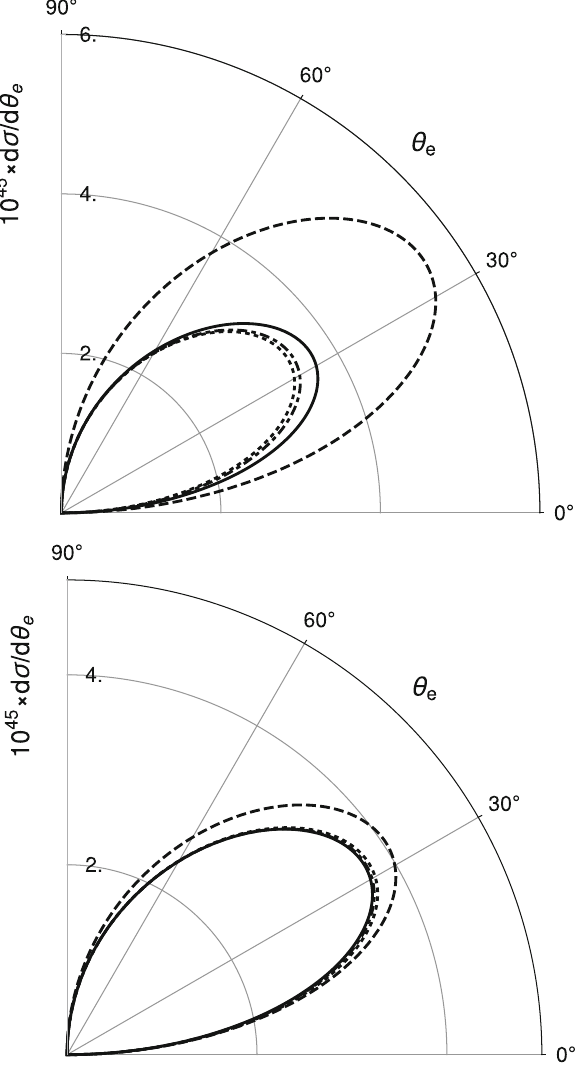
Fig. 9 Plot of d σ/ d θ e as a function of θ e for θ ν = π/ 2, E ν = 1 MeV , | = 0 . 2 ,θ = 0 T , R φ ν = 0. Upper plot for TRSC: standard V − A interaction (solid line); T | = 0 . 2 ,θ = 0 S , R | = 0 . 2 ,θ = 0 (dashed S the combination of V − A and T R when | c R T , R T | = 0 . 2 ,θ = 0(dashed-dotted P , R | = 0 . 2 ,θ = 0(dottedline); P line);thecaseof V − A and S R when | c R S , R S | = 0 . 2 ,θ = 0 (dashed-dotted line). Lower V − A with P R when | c R | = 0 . 2 ,θ = π/ 2 (dashed P , R P T , R T plot for TRSV: standard V − A interaction (solid line); the combination | = 0 . 2 ,θ = π/ 2 (dotted S , R | = 0 . 2 ,θ = π/ 2 (dashed line); the case S of V − A and T R when | c R T , R T | = 0 . 2 ,θ = π/ 2 (dashed-dotted P , R | = 0 . 2 ,θ = π/ 2 (dotted line); V − A P of V − A and S R when | c R S , R S | = 0 . 2 ,θ = π/ 2 (dashed-dotted line) with P R when | c R P , R P